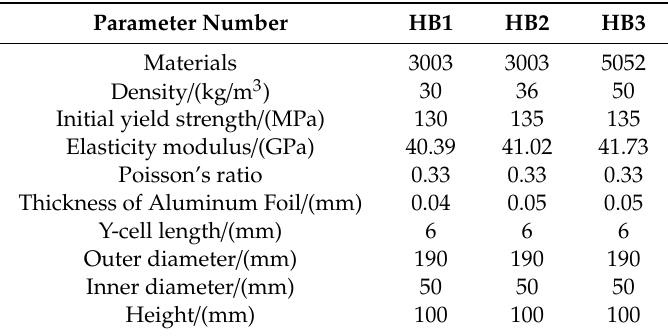
Table 1. Bu ff er material experiment